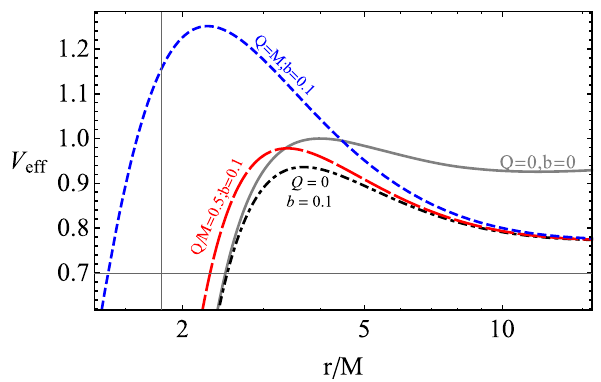
Fig. 1 The radial profiles of the effective potential for radial motion of magnetized particles with the specific angular momentum L / M = 4, around the electrically charged RN black hole for the different values of the electric charge of the black hole and the magnetic coupling param- eter